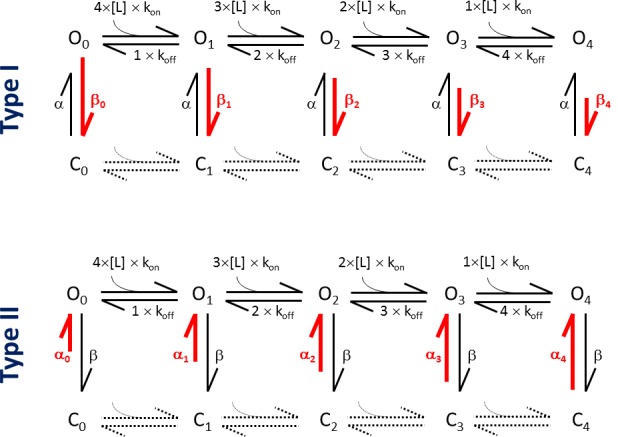
Kinetic schemes of the MWC model, depicting the differential effects of Type I and Type II ligands.